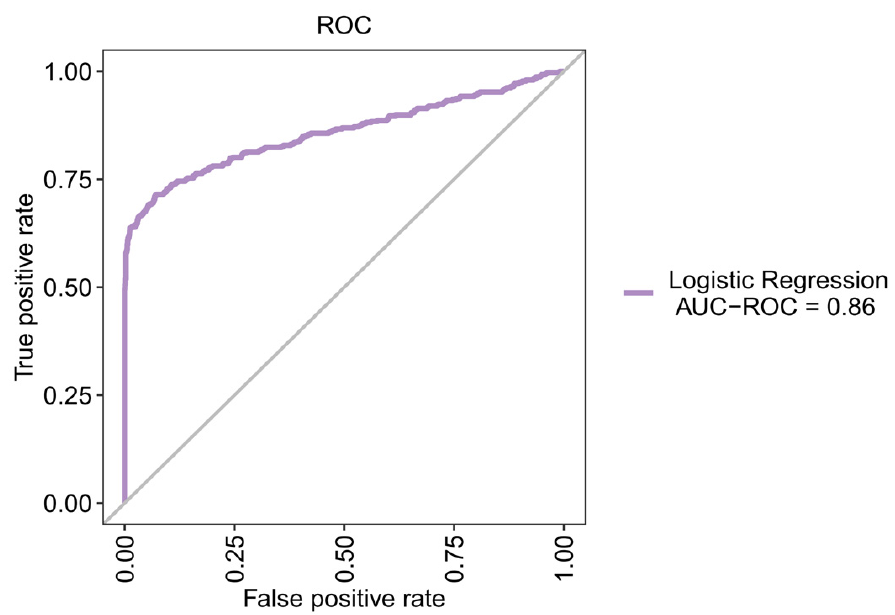
Figure 5. ROC-AUC for a NEW logistic regression model. ROC-AUC for predicting patient weaning within 24 h. ROC-AUC: Receiver operating characteristic curve area under the curve. cutoff value being